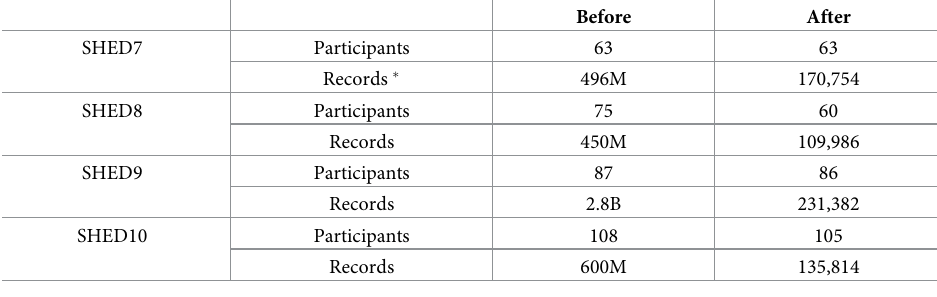
Table 2. Dataset information before and after data